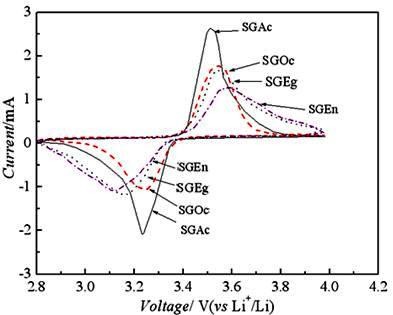
Cyclic voltammetry curves of LiFePO4/C.